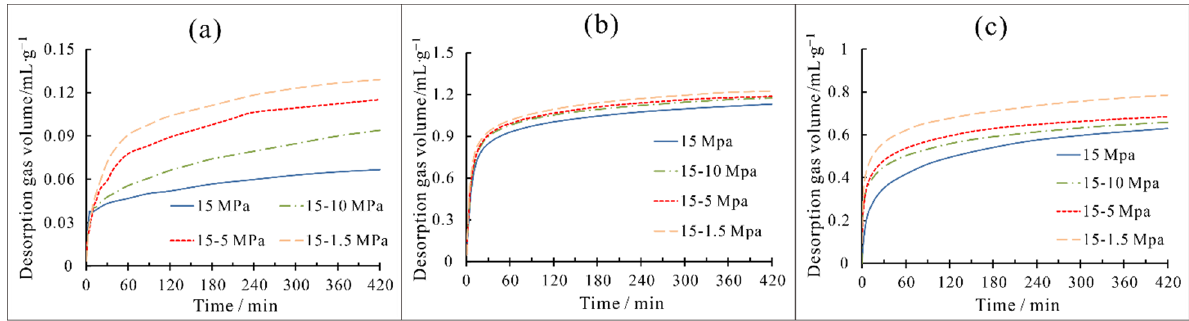
Figure 10. Changes in desorption gas volume under stress reduction: ( a ) is the PUC sample; ( b ) is the BDC sample; ( c ) is the DDC